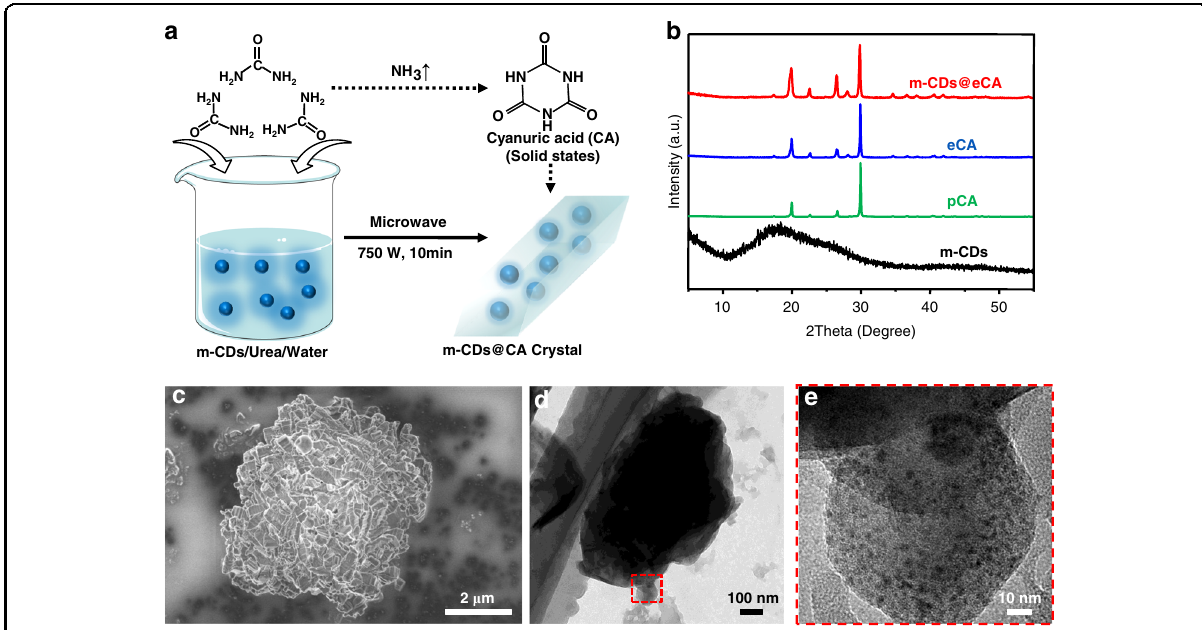
Fig. 2 The preparation process and structure characteristics of m-CDs@CA. a Schematic illustration of the preparation process of m-CDs@CA and the conversion from urea to CA. b XRD patterns of m-CDs, pCA, eCA, and m-CDs@CA. c – e High-resolution SEM, TEM, and high-resolution TEM (red area in d ) images of